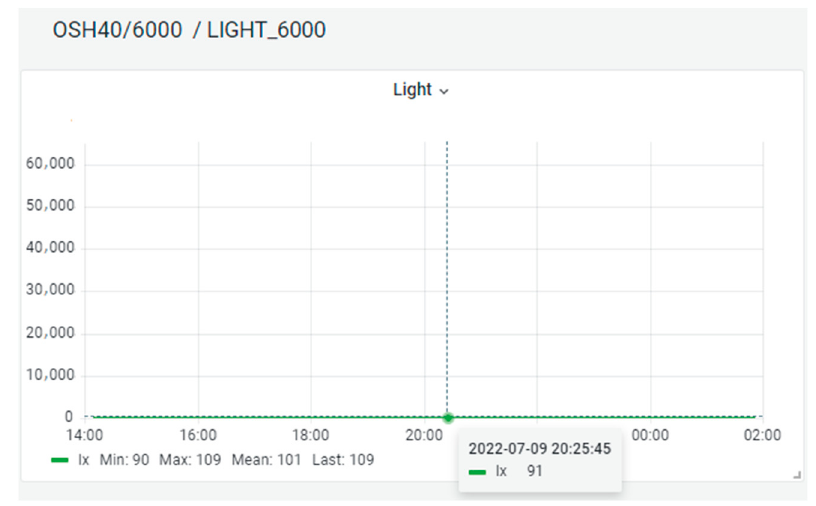
Figure 7. Illuminance graph.